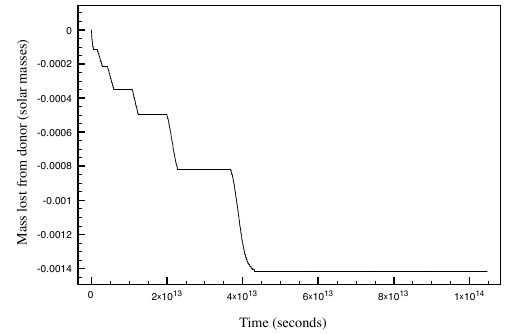
mass of the donor.